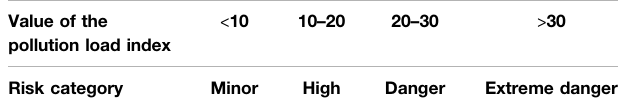
TABLE 2 | Terminology used to describe the risk level criteria for MP pollution according to Ranjani et al. (2021) and Xu et al.